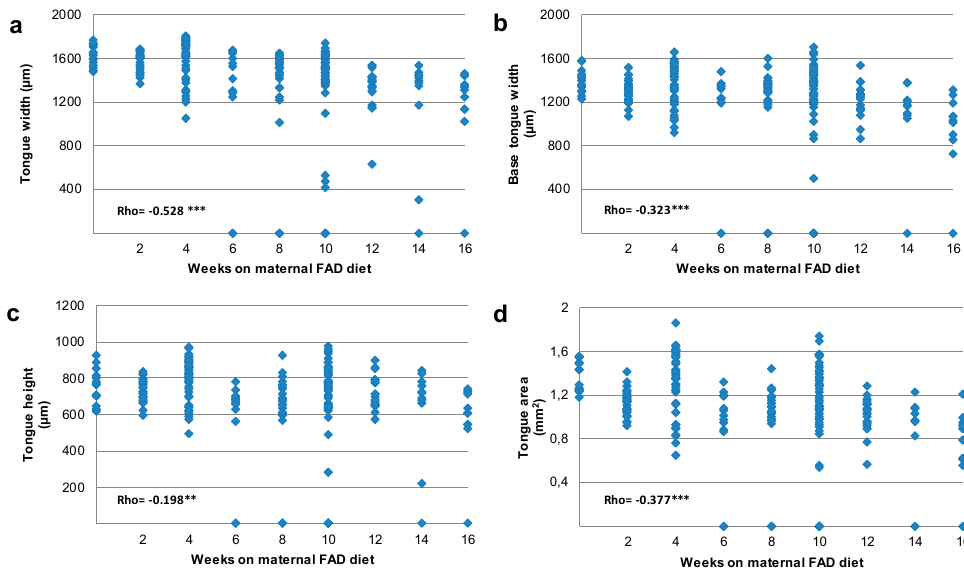
Figure 3. Correlation between tongue width ( a ); base of the tongue width ( b ); tongue height ( c ) and tongue area ( d ) with weeks on maternal FAD diet. ** p ≤ 0.01; *** p ≤ 0.001 Spearman’s Rho. Nutrients 2018 , 10 , 26